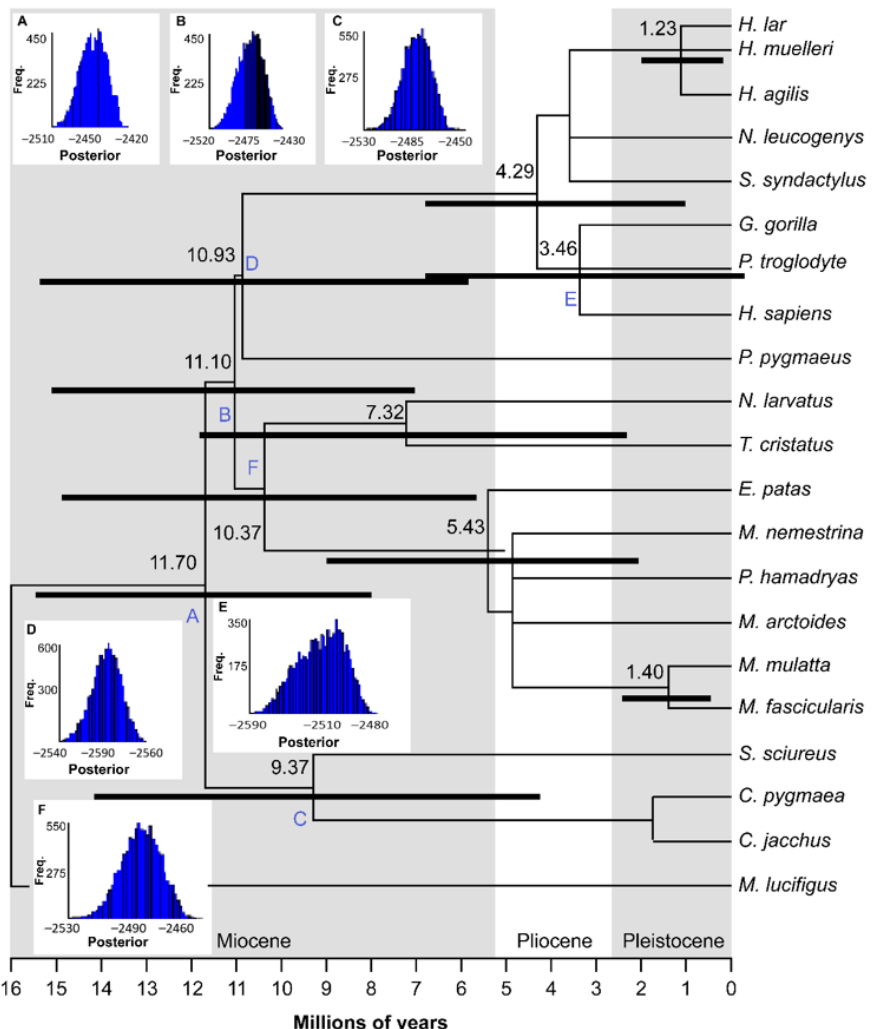
Figure 2. Expanded chronogram of selected single individuals representing each species of primate studied. Values at each node represent estimates of the meantime to the most recent common ancestor from dating analyses performed in BEAST version 1.7.5. Black bars represent the 95% highest posterior density (HPD) intervals for the divergence estimates. Reference fossil dates used for calibration of the tree in dating algorithms are represented by letters A–F on nodes. ( A ) mean = 43.0 MYA, standard deviation (stdev) = 4.5 for time to most recent common ancestor (TMRCA) of Simiiformes. ( B ) mean = 29.0 MYA, stdev = 6.0 for TMRCA of Catarrhini, ( C ) mean = 23.5 MYA, stdev = 3.0 for TMRCA of Platyrrhini, ( D ) mean = 15.5 MYA, stdev = 2.5 for TMRCA of Hominidae, ( E ) mean = 6.5 MYA, stdev = 0.8 for TMRCA of Homo - Pan , ( F ) mean = 17.6 MYA, stdev = 1.0 for TMRCA of Cercopithecinae and Colobinae. Outgroup ( M . lucifugus ) is